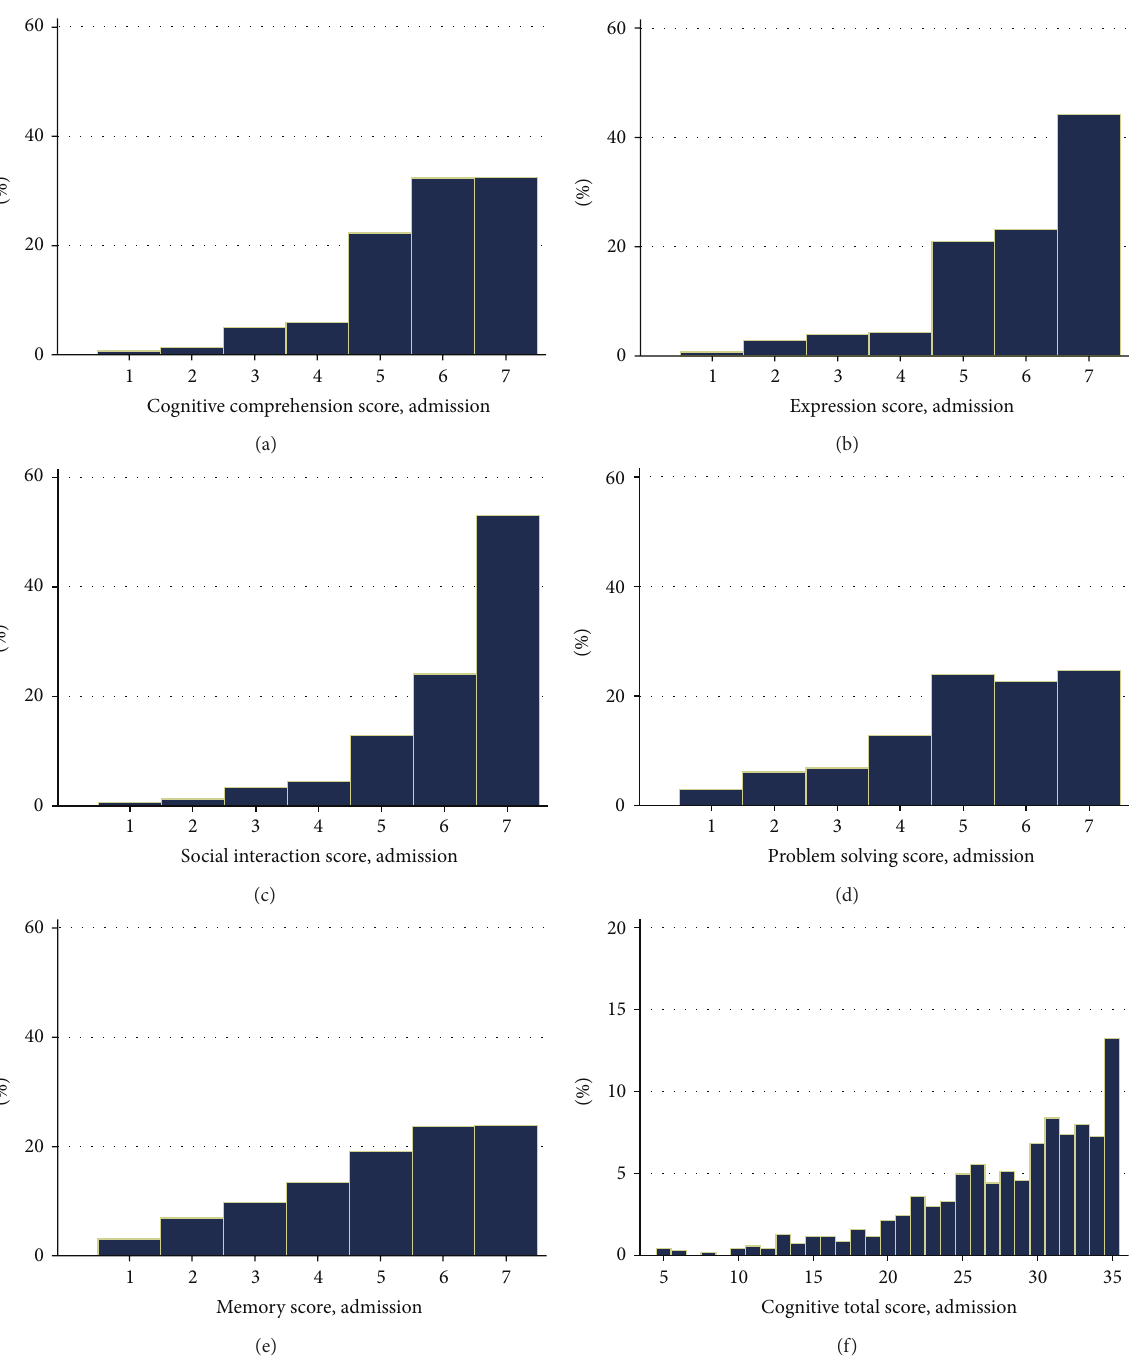
Figure 1: Frequency of Functional Independence Measure Cognitive items scores ((a) to (e)) and total Cognitive score (f) at admission